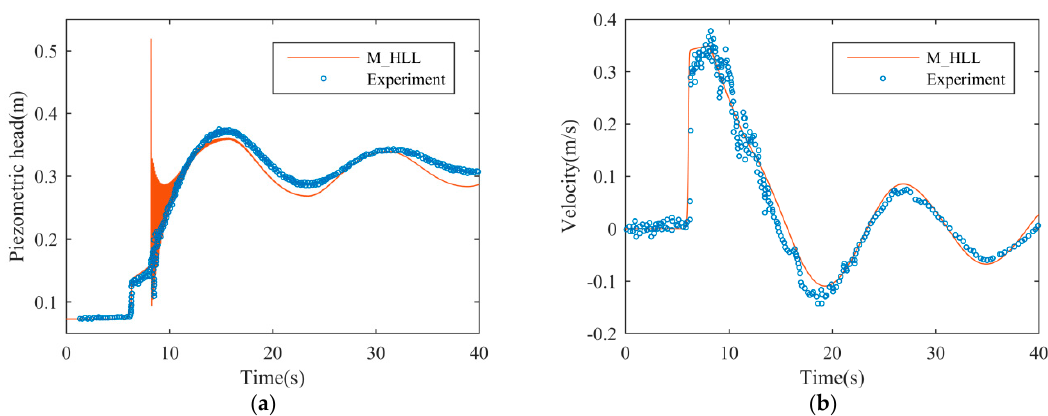
Figure 22. Locus of flow states at x = 9.9 m simulated by M_HLL ( K a = 1.2 and NS = 12) and experimental data: ( a ) piezometric head; ( b ) flow velocity.